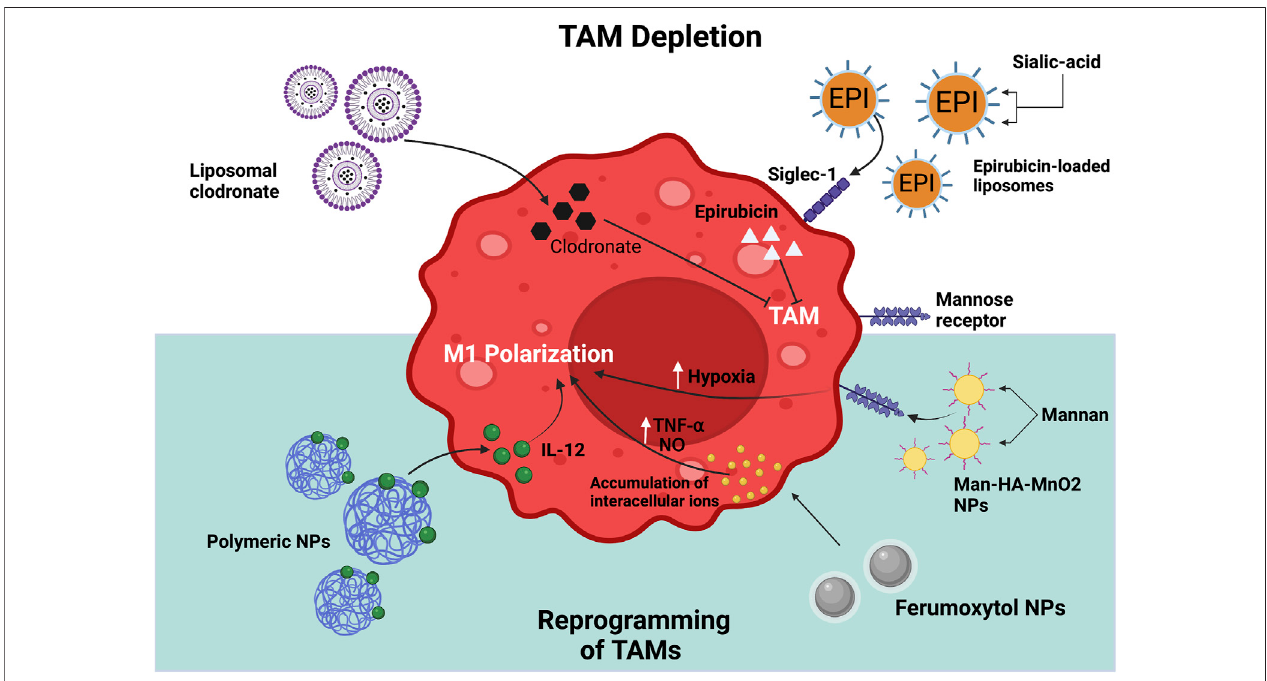
FIGURE 3 | Strategies for targeting TAMs using NPs. The main approaches involve depletion of TAMs in TME; and reprogramming of TAMs to a M1 phenotype. The fi gure illustrates different types of NPs that have been used to target TAMs and their mechanism of action in macrophages. Created with Biorender.com.